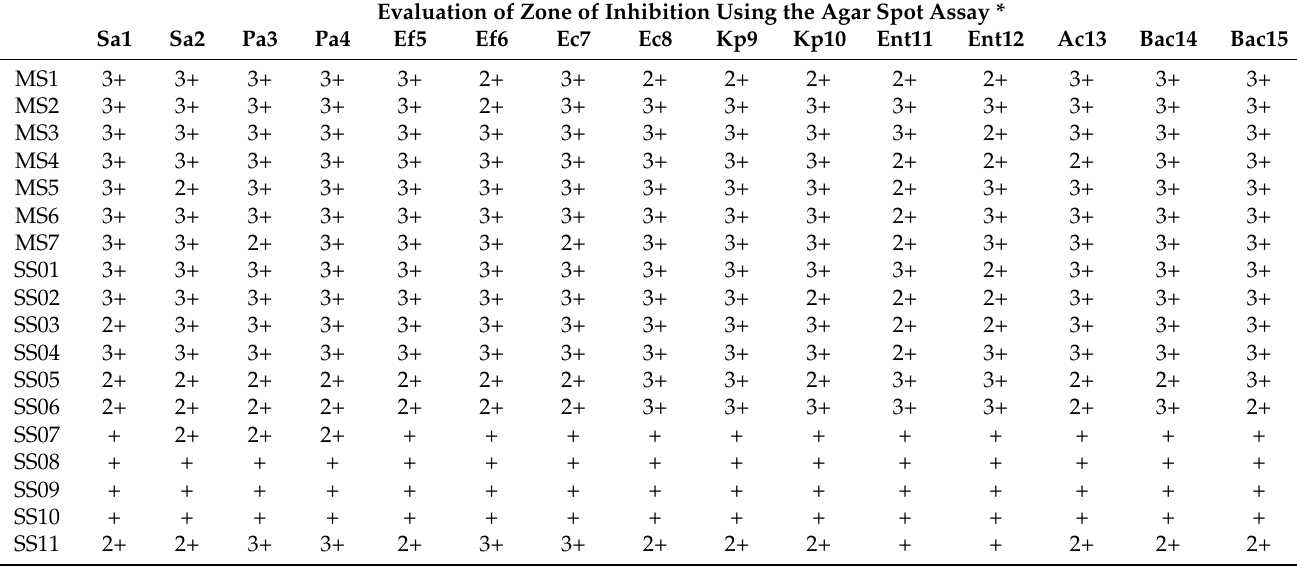
Table 8. Evaluation of the antagonistic effect of various probiotics and other beneficial microbes against clinical skin pathogens using the agar spot